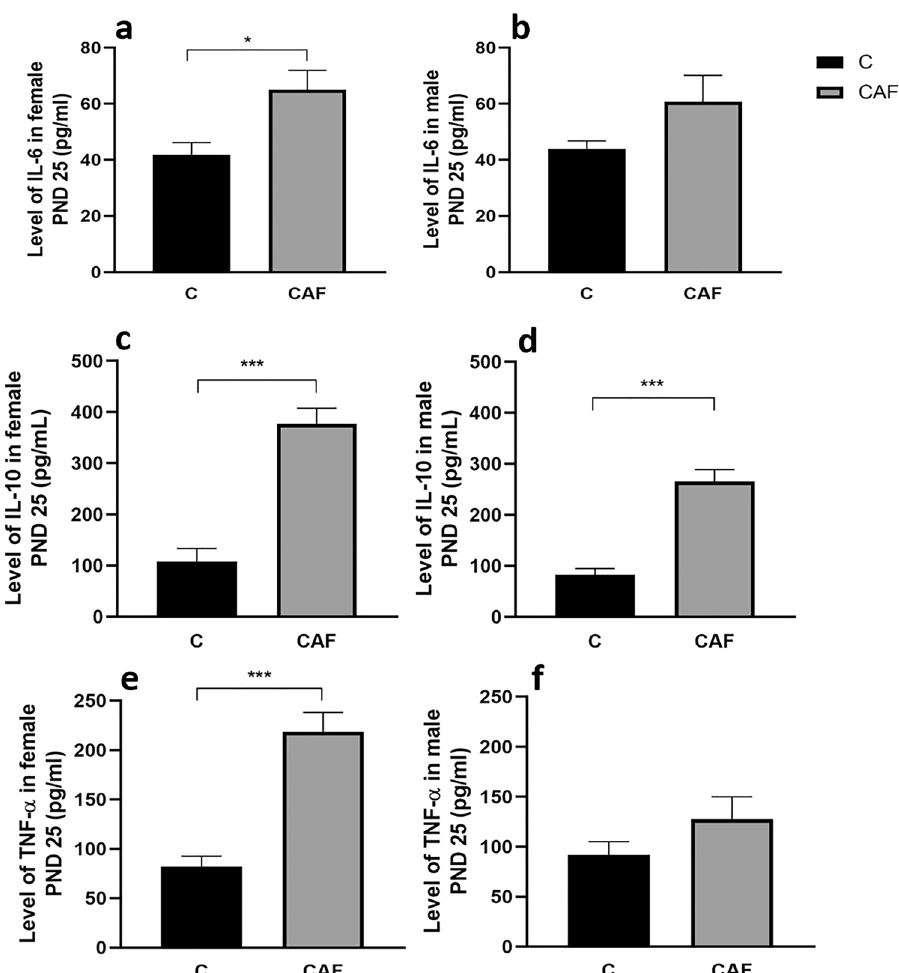
Figure 6. Inflammation status in offspring on PND 25. ( a ) Level of interleukin 6 (IL-6) in female offspring (*p < 0.05); ( b ) IL-6 level in male offspring (p = 0.12); ( c ) level of interleukin 10 (IL-10) in female offspring (***p < 0.005); ( d ) blood serum level of IL-10 in male offspring (p < 0.005); ( e ) level of tumor necrosis factor alpha (TNF-α) in female offspring (***p < 0.005); ( f ) level of TNF-α in male offspring (p = 0.20). C control group, CAF cafeteria group; n = 5/sex/group for all